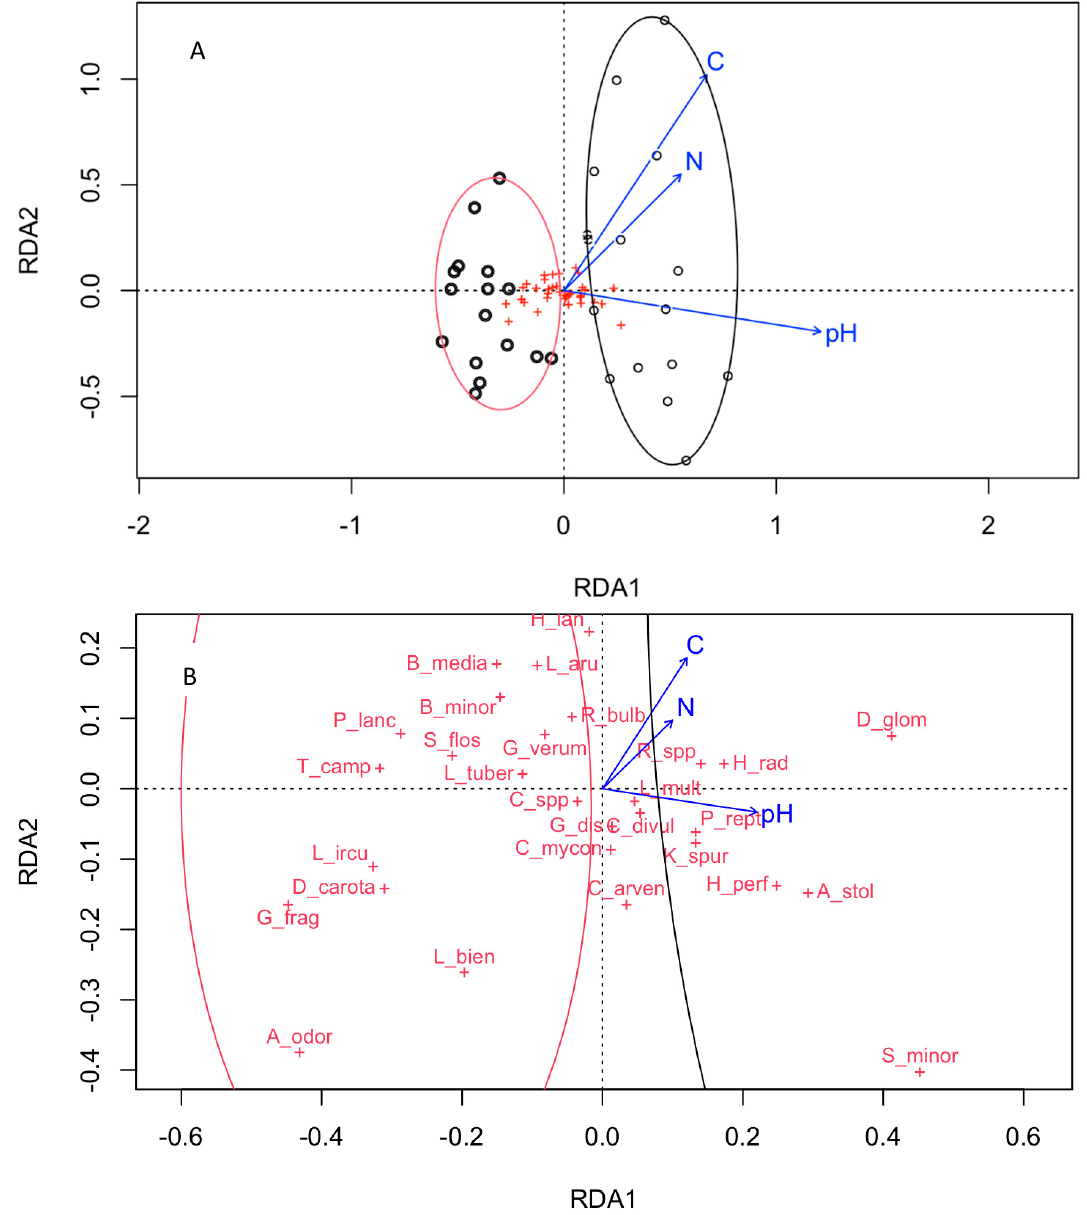
Figure 4. Ordination biplot of redundancy analysis (RDA) representing shared effects of two sets of explanatory variables (soil properties and management). C = total organic carbon; N = total nitrogen. ( A ) Circles in bold represent the HM plots, circles not in bold represent the AM plots, crosses represent the species. ( B ) the species reported are: A_odor = A. odoratum , A_stol = A. stolonifera , B_media, B_minor, C_divul = C. divulsa , C_mycon = C. myconis , C_arven = C. arvensis , C_spp = Cyperus sp., D_glom = D. glomerata , D_carota, L_aru = L. arundinaceum , G_verum, G_frag = G. fragilis , G_dis = G. dissectum , H_lan = H. lanatus , H_perf = H. perforatum , H_rad = H. radicata , K_spur = K. spuria , L_tuber = L. tuberosus , L_ircu = L. ircutianum , L_bien = L. bienne , L_mult = L. multiflora , P_lanc = P. lanceolata , P_rept = P. reptans , R_bulb = R. bulbosus , R_spp = Rubus sp., S_minor, S_flos = S. flos-cuculi ,